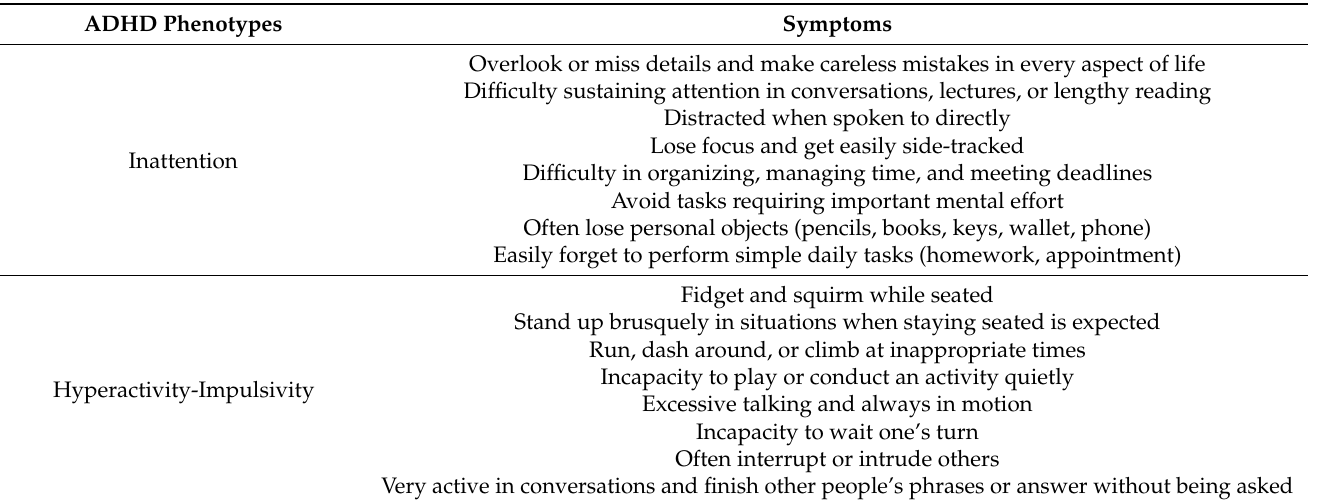
Figure 3. Overall prevalence of ADHD in children vs. adults in select countries in 2017. Prevalence varies depending on the country [29,30]. Table 2. ADHD phenotypes and their components. The main symptoms observed in ADHD individuals are presented depending on ADHD